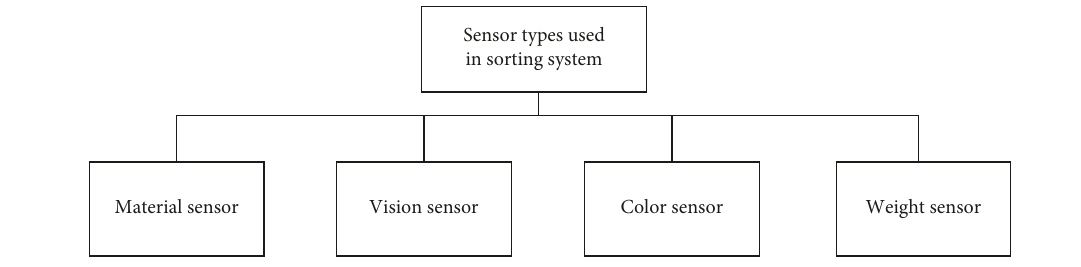
Figure 1: Sensor types that are used in sorting systems. Table 1: The sensors and methods that are used in sorting operations.